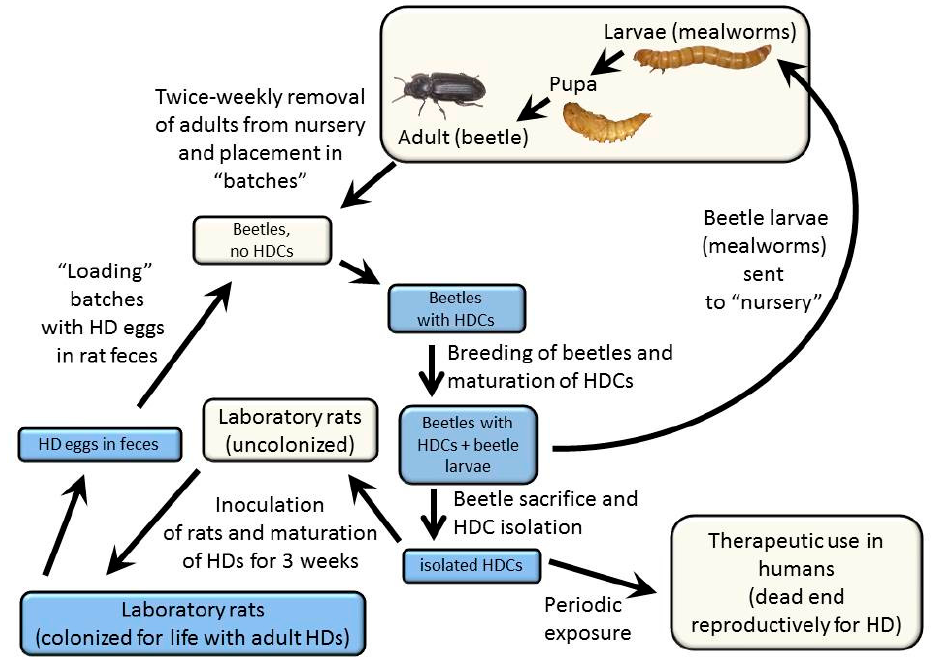
Figure 1. Schematic diagram showing maintenance of the rat tapeworm in laboratory rats (primary hosts) and grain beetles (secondary hosts) as described in the text. Blue boxes indicate steps that include live Hymenolepis diminuta , either eggs, Hymenolepis diminuta cysticercoids (HDCs), or adult tapeworms.